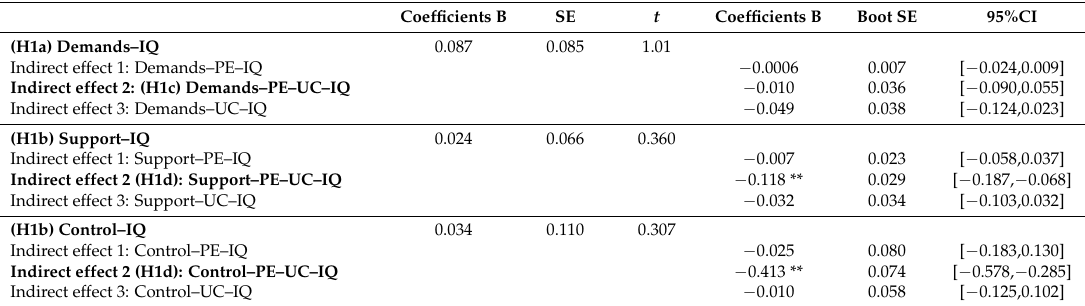
Table 3. Results of mediation test of psychological empowerment and union commitment between demands-resources and intention to quit the